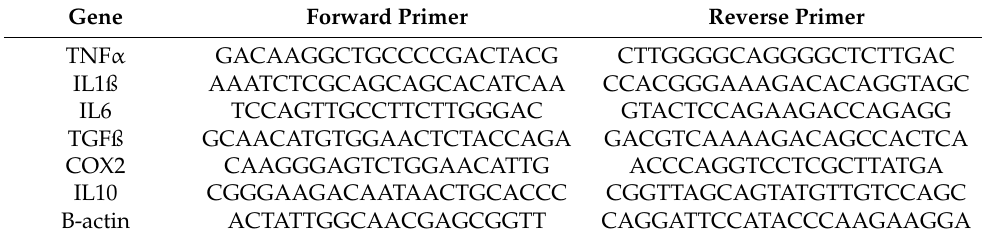
Table 1. Primers used for real-time